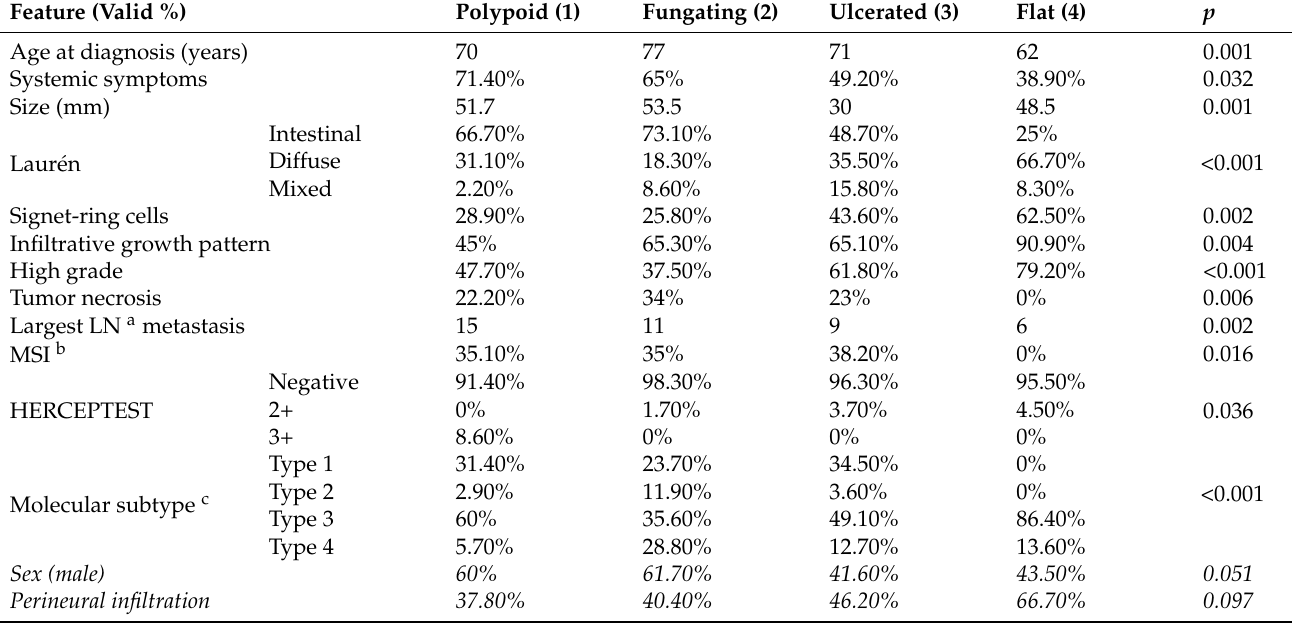
Table 2. Univariate analysis. Clinicopathological features significantly related to Borrmann